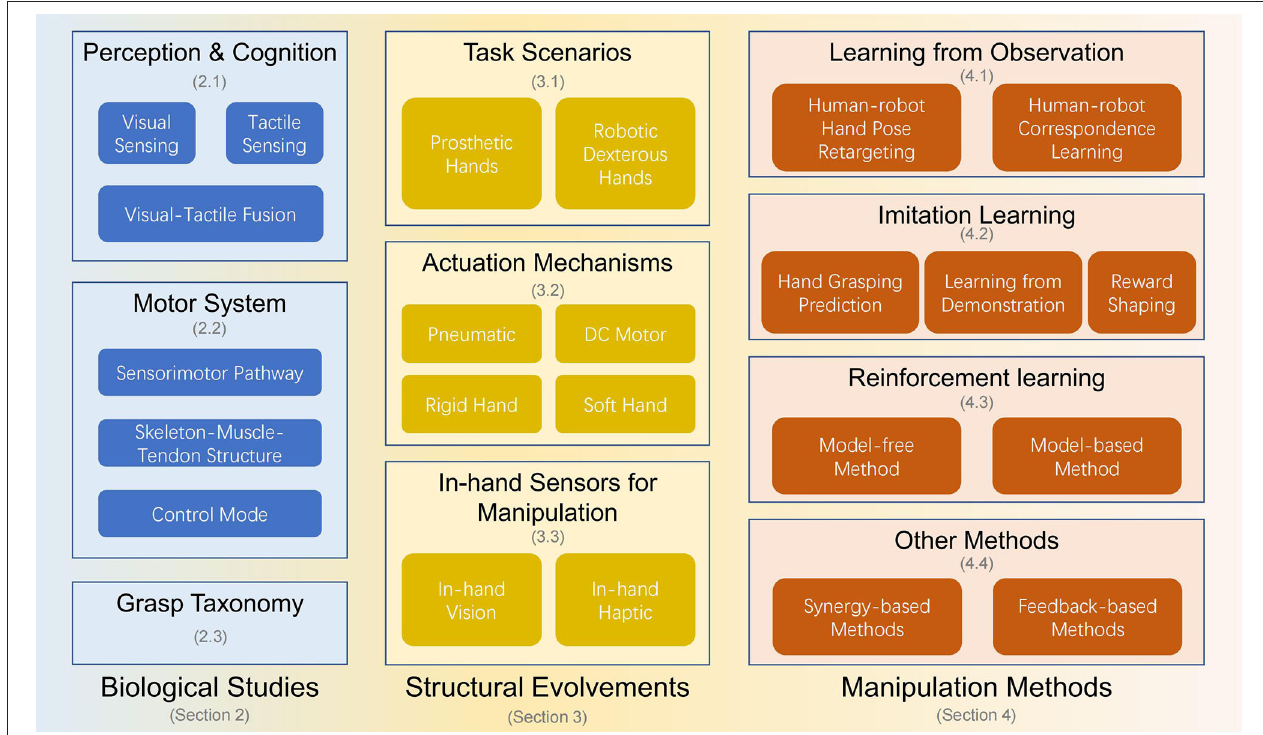
FIGURE 1 | The brief overview of the organization of the